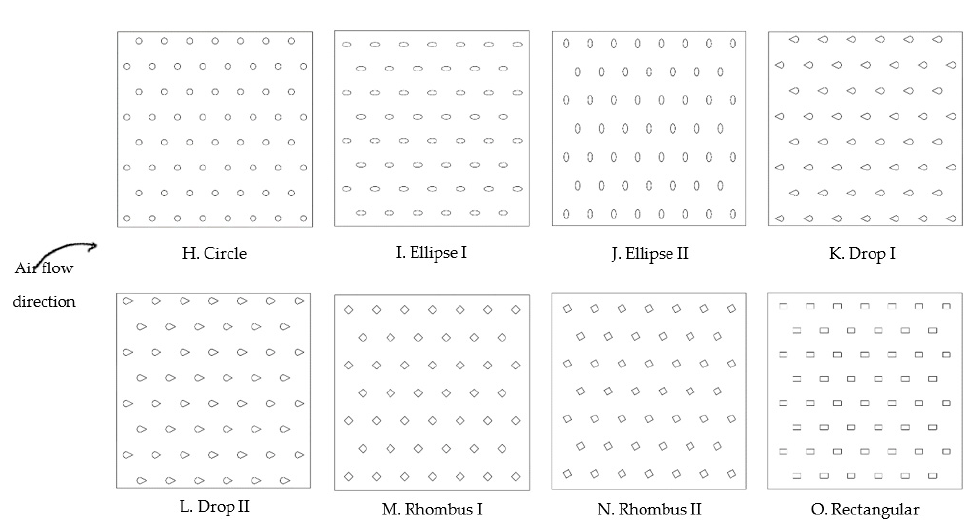
Figure 4. Different fins heat sink models.